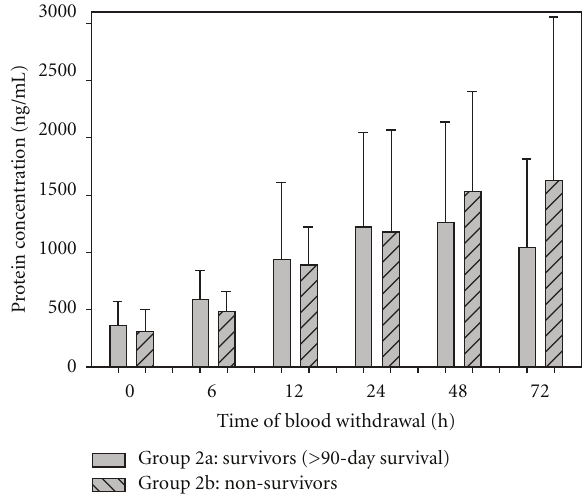
Figure 7: Mean TIMP-1 serum levels were lower in non-survivors (group 2b) than those in survivors (group 2a) within the first 24 h after multiple major injuries. 48h and 72 h after trauma, mean TIMP-1 serum levels of non-survivors were higher than mean protein levels of patients who survived 90-days after the traumatic event. Data were analyzed by Mann-Whitney Rank Sum test and presented by mean ± standard error of the